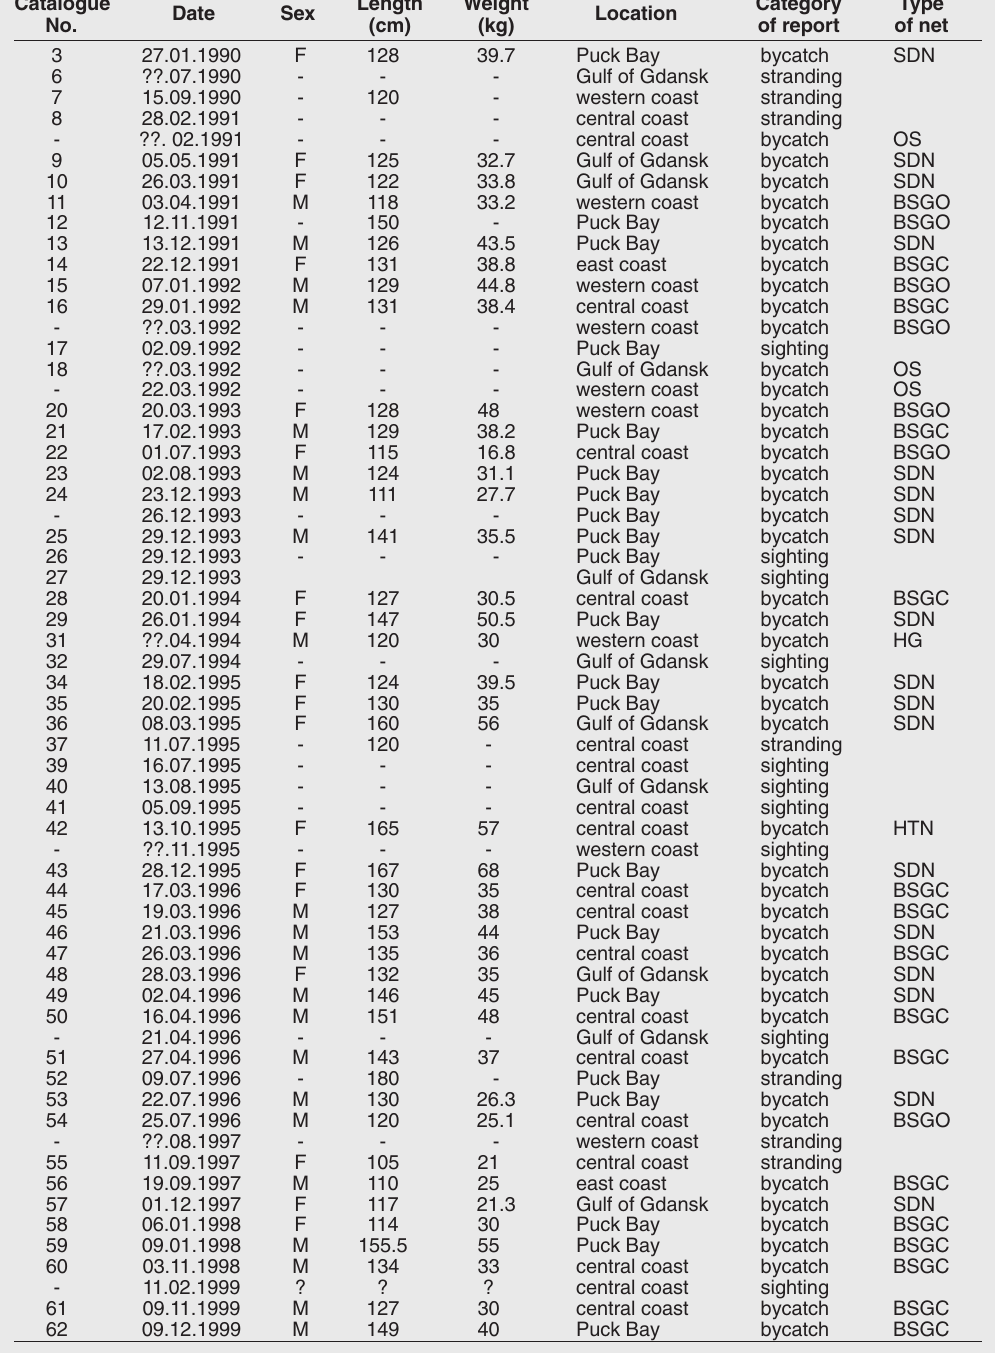
Table 1. Biological information and location of harbour porpoises bycaught, stranded or sighted in Polish waters during 1990-1999. For bycaught animals, the type of fishing gear is also indicated. Geographical subregions are shown on Fig. 2. Types of nets: SDN=semi-drift net; BSGC=bottom set gillnet for cod; BSGO=bottom set gillnet for other fish; HG=herring gillnet; HTN=herring trawl net; OS=other set